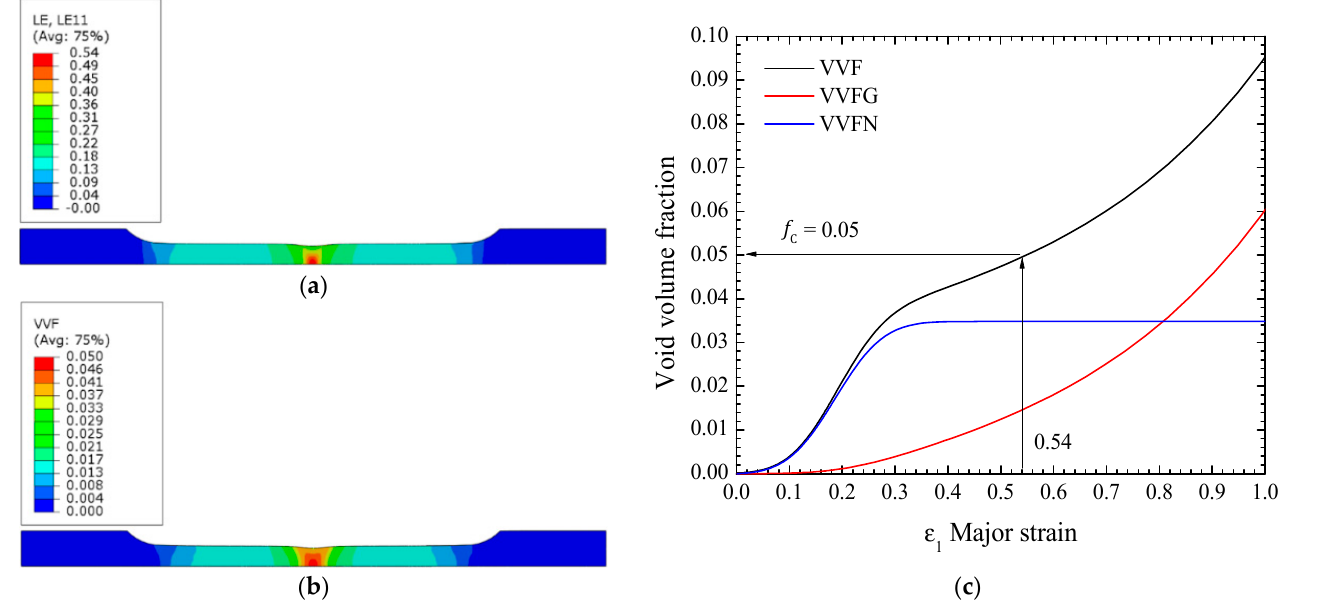
Figure 16. Proposed identification procedure for the critical void volume fraction f c -value: contours plots of the ( a ) major strain and ( b ) void volume fraction, and ( c ) void volume fraction measures as a function of the major strain in the necking region.